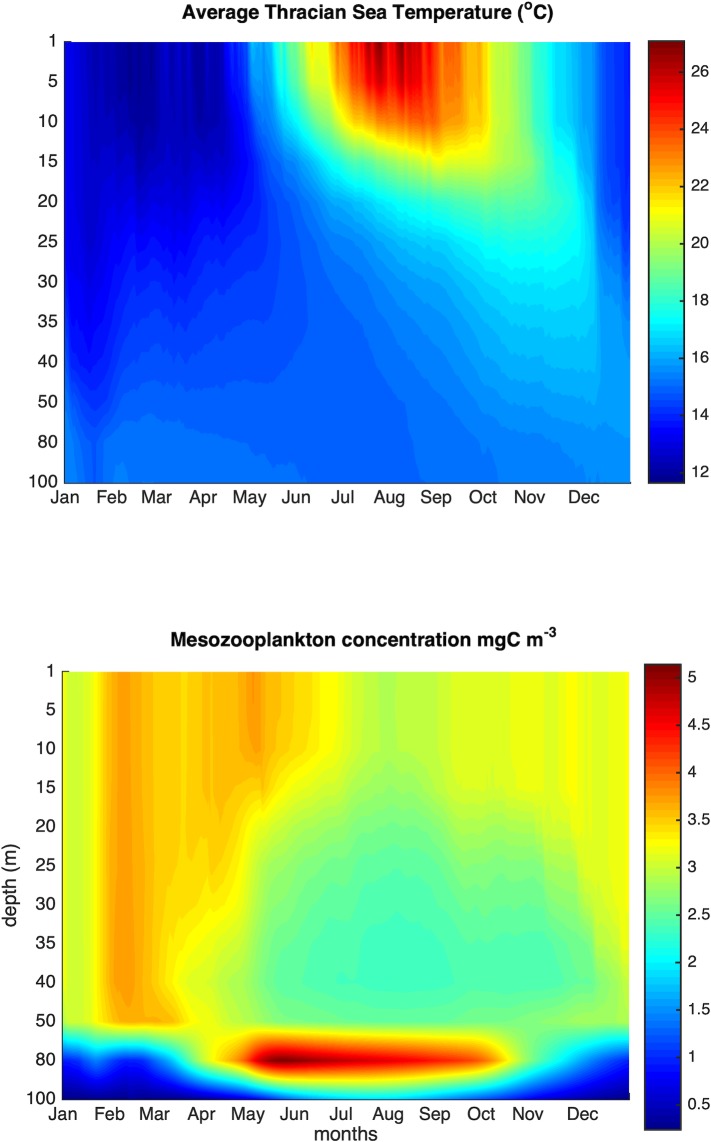
Seasonal evolution of temperature and simulated mesozooplankton concentration.